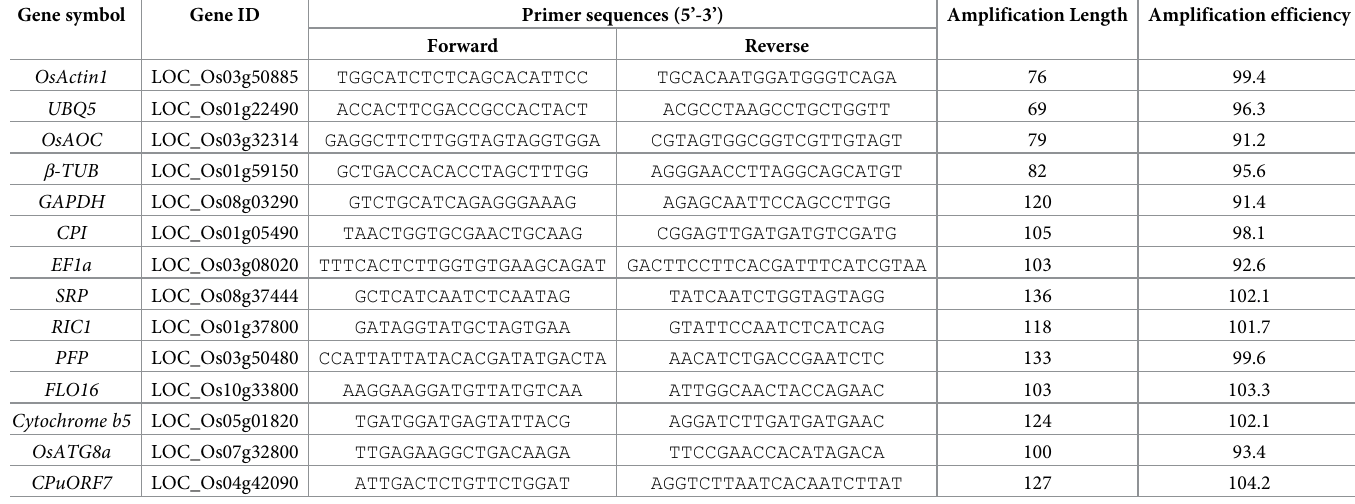
Table 1. Description of the candidate reference genes, primer sequence and qRT-PCR amplification efficiencies. Gene symbol Gene ID Primer sequences